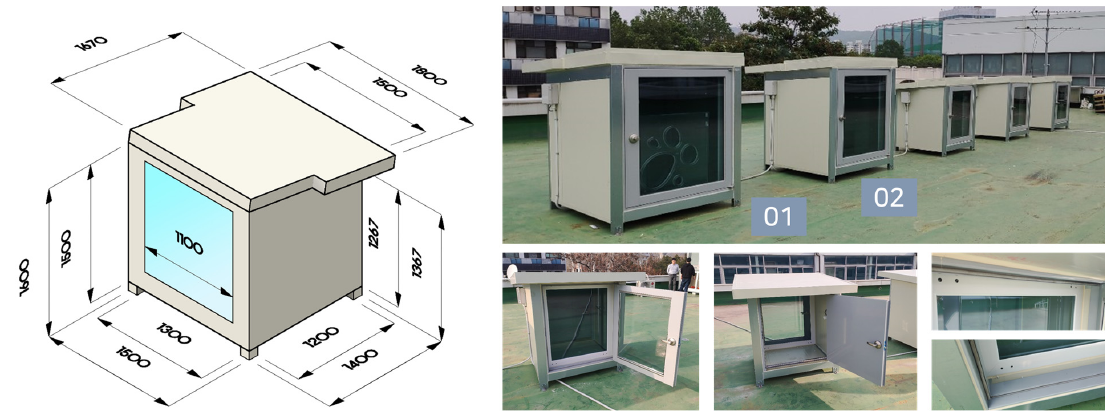
Figure 4. Construction of mock-up (Reprinted from Ref. [26]).